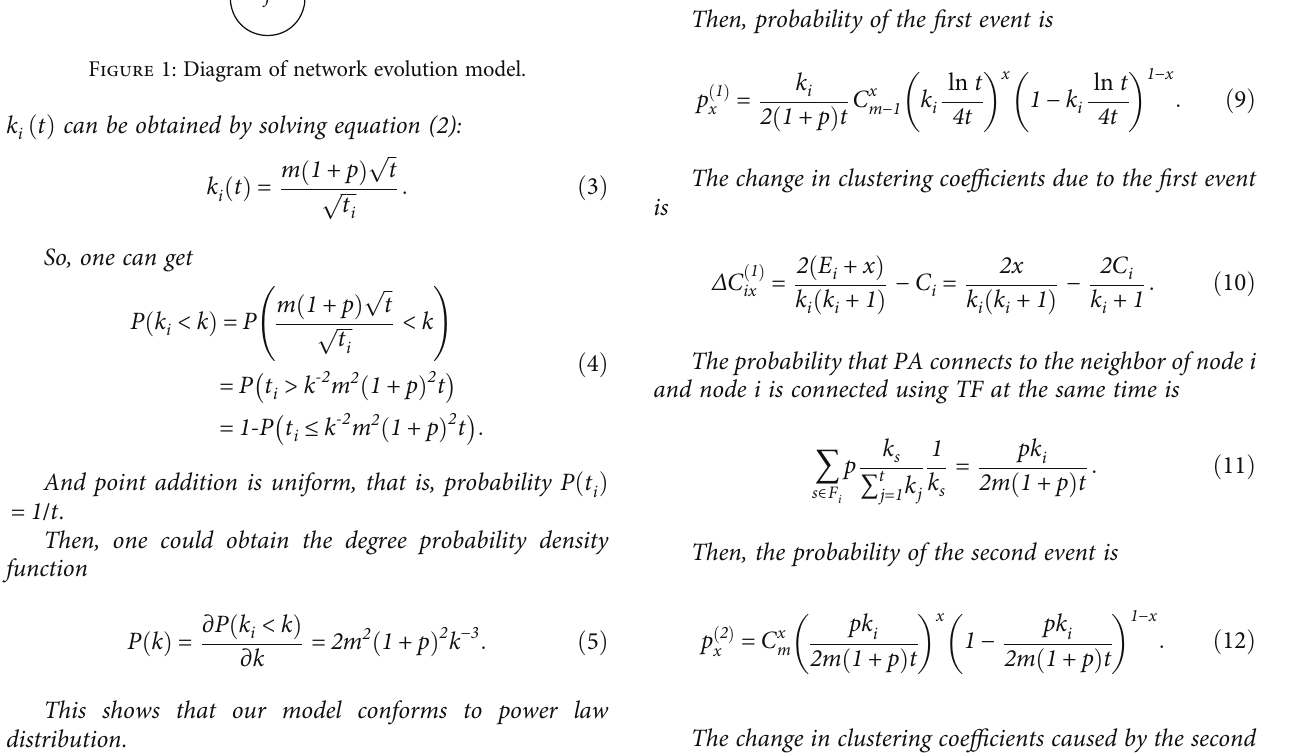
Figure 1: Diagram of network evolution